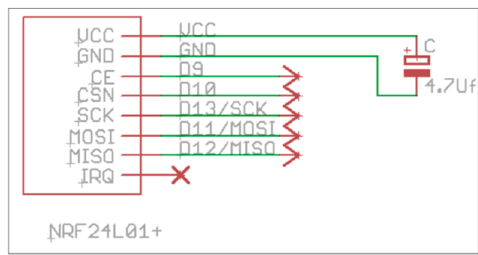
Figure 5. Communication technologies analysed.